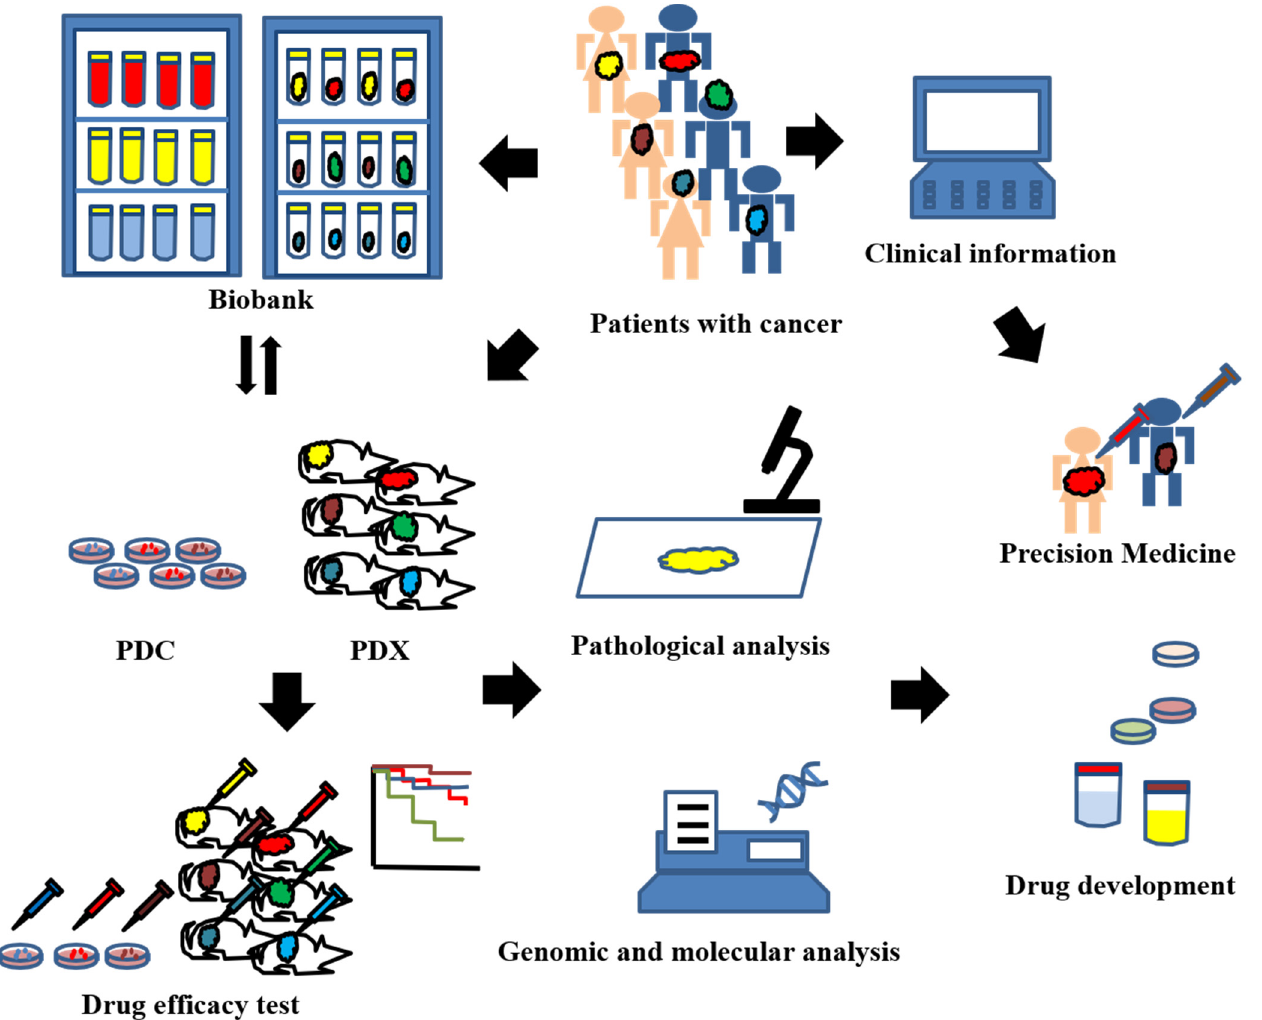
Figure 1. Schematic for the use of patient-derived xenograft (PDX) models. PDX models can be created by grafting the tissue obtained by surgery or biopsy into immunodeficient mice. Patient-derived cells (PDCs) are also created from tumors. All materials and information from cancer patients and PDX models are stored in biobanks and data banks. The materials include all samples obtained from patients or PDX models, such as blood, urine, discharge, and tumors. The information also includes clinicopathological, genomic analysis, and drug sensitivity data. These materials and information in biobanks and databanks are intended for use in precision medicine and the development of anticancer agents; this platform allows many researchers to share all types of information and conduct experiments with PDXs that reflect the characteristics of the primary tumor.